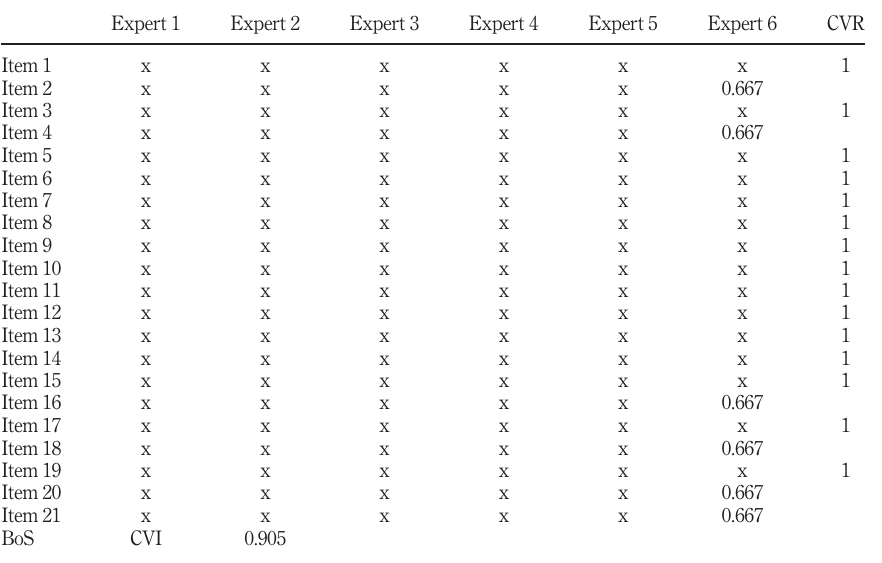
Table 1. Content validity